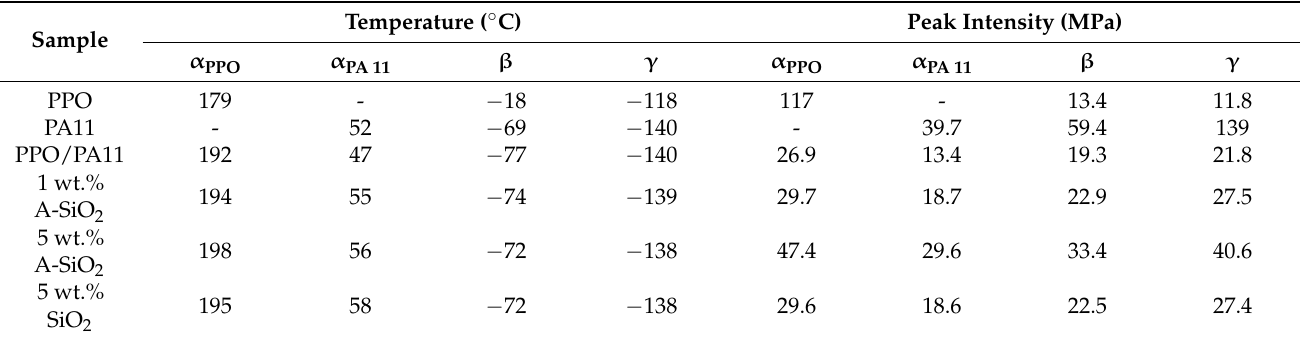
Table 3. DMTA data of PPO, PA11, and PPO/PA11/silica